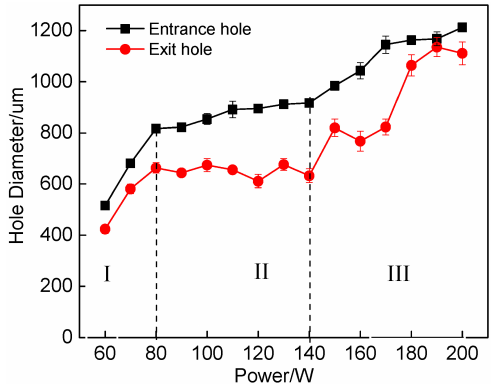
Figure 4. Variation of mean diameters and S dev of entrance and exit circles with laser